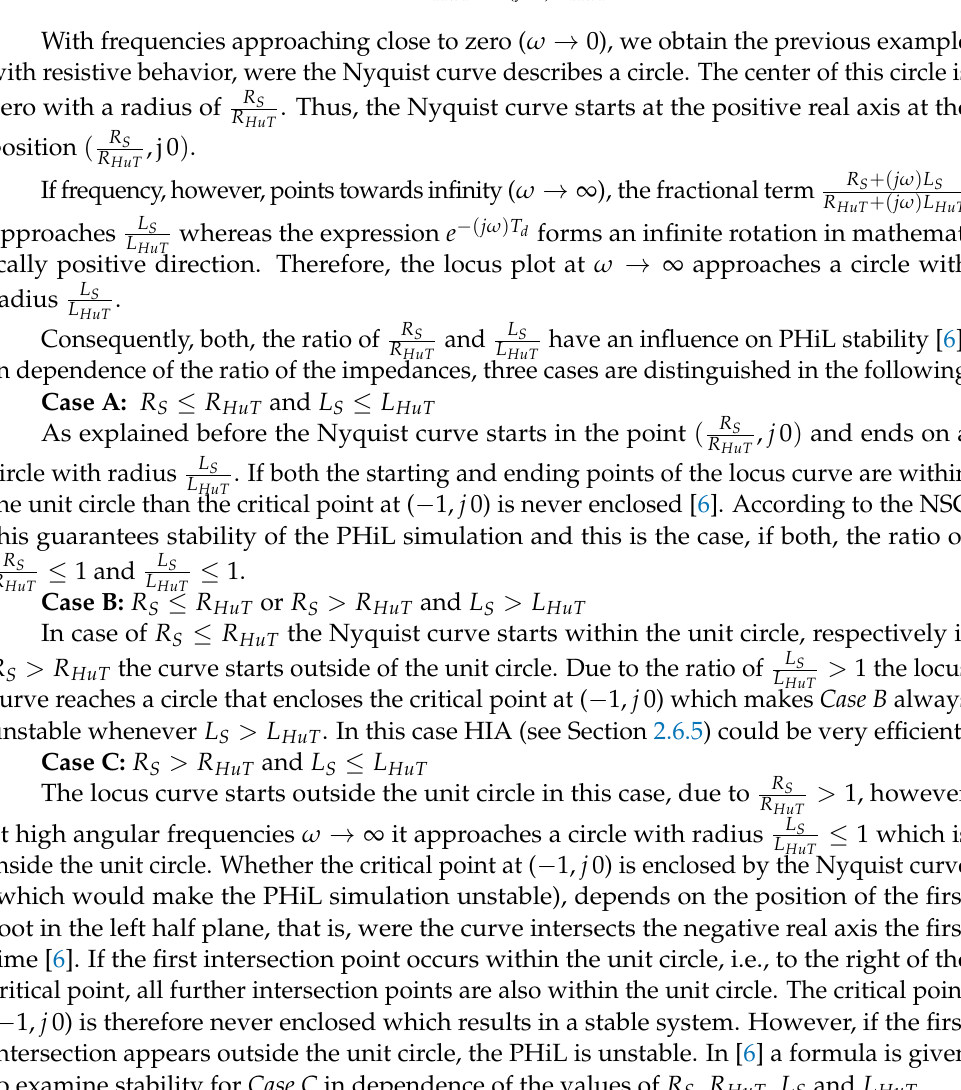
Figure 10. Locus plot with the angular frequency as an additional dimension.